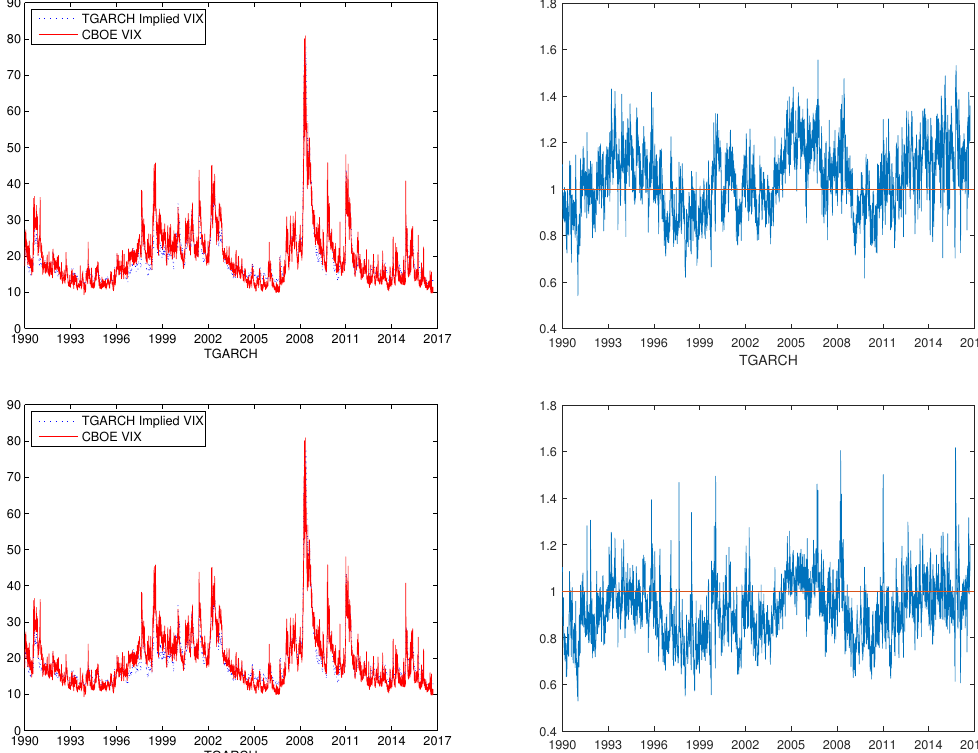
Figure 5. Comparison between CBOE VIX and implied VIX of the TGARCH(1,1) model using both returns and VIX data with the upper panel showing the result under the mLRNVR and the lower panel showing the result under the LRNVR. The left panels show the index values of CBOE VIX and implied VIX and the right panels show the ratio of the implied VIX to CBOE VIX and a horizontal line at 1 for